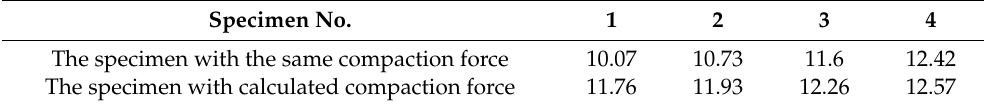
Table 4. The average peeling